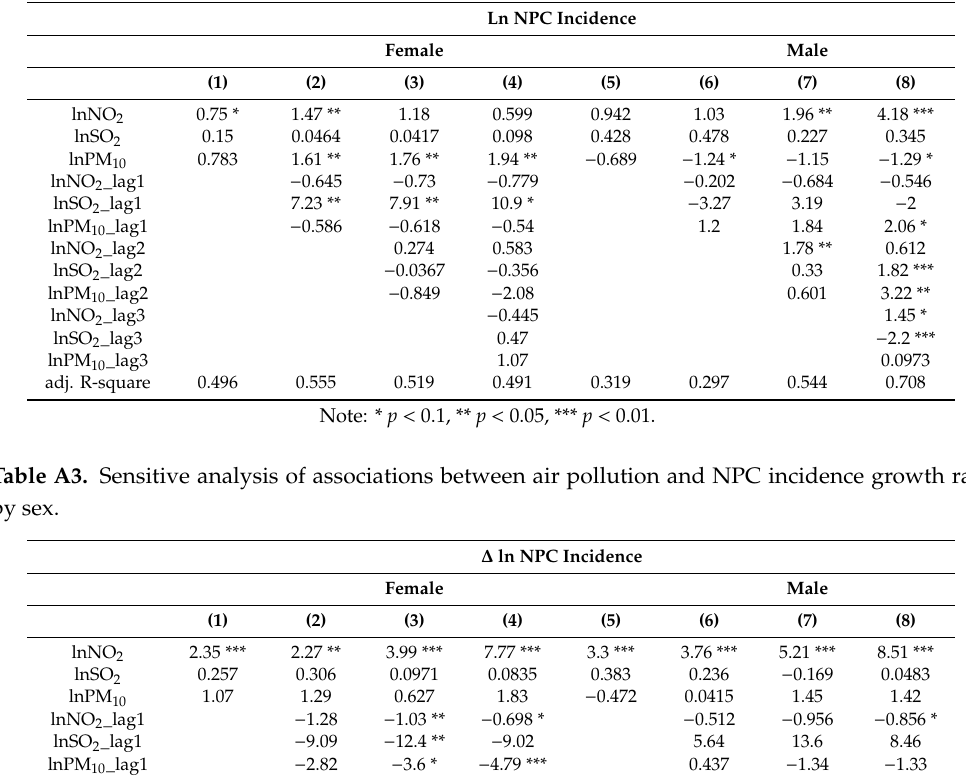
Table A2. Sensitivity analysis of association between air pollution and NPC incidence by sex.